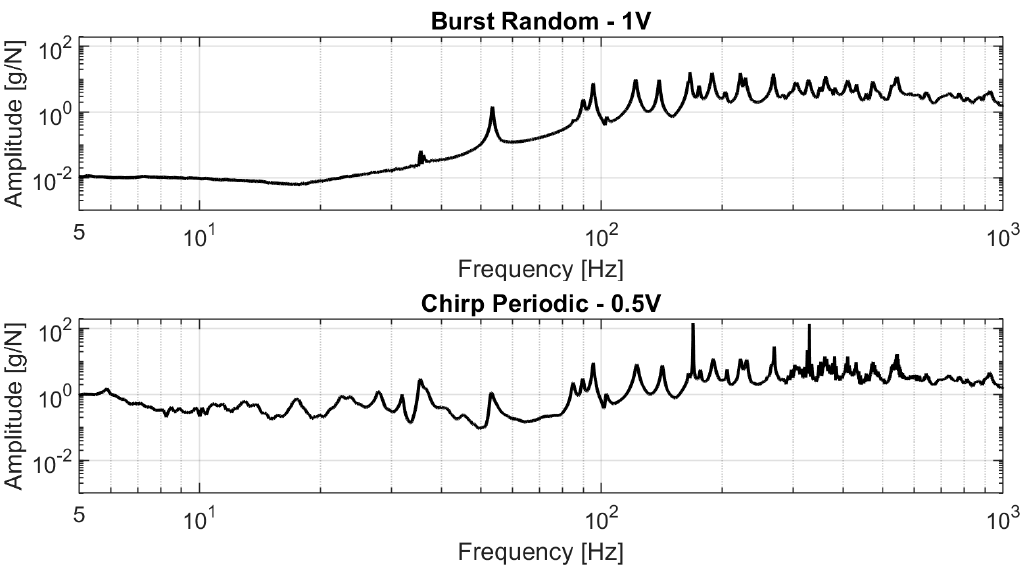
Figure 4. Sum of frequency response functions (FRFs), limited to 5–1000 Hz, estimated in two tests performed on panel PN .